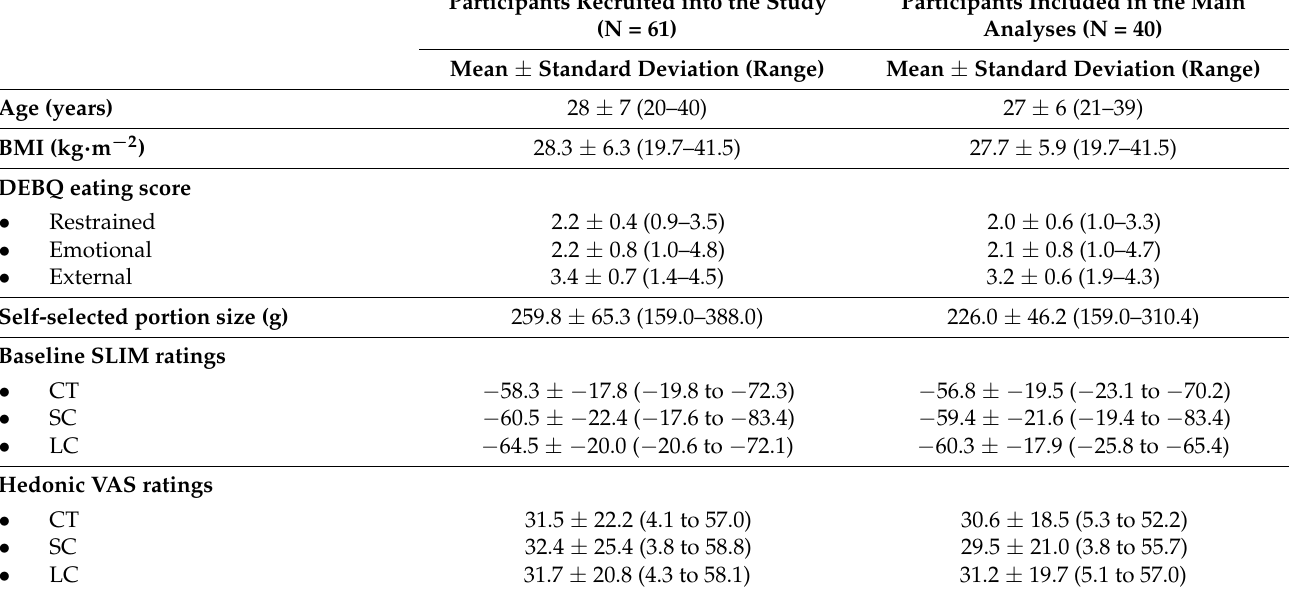
Table 1. Summary of participant characteristics, self-selected portion size (g), and baseline Satiety Labeled Intensity Magnitude (SLIM) ratings across the three experimental sessions. Baseline SLIM ratings are reported for each small jar size condition (SC), medium jar size condition (control, CT), and large jar size condition